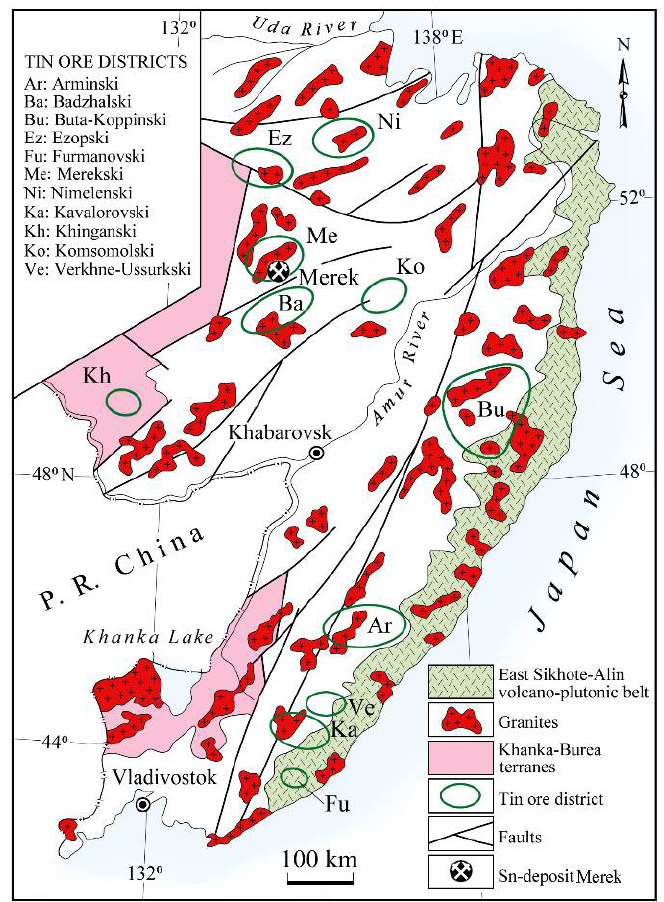
Figure 7. Distribution of Mesozoic intrusive bodies and tin ore districts, the southern Russian Far East (modified from [26]).